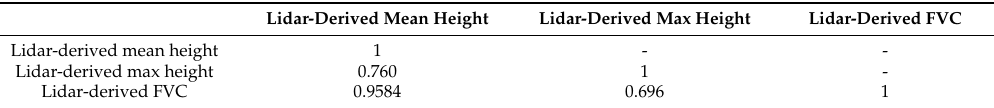
Table 5. Pearson’s correlations ( r ) between the lidar-derived canopy